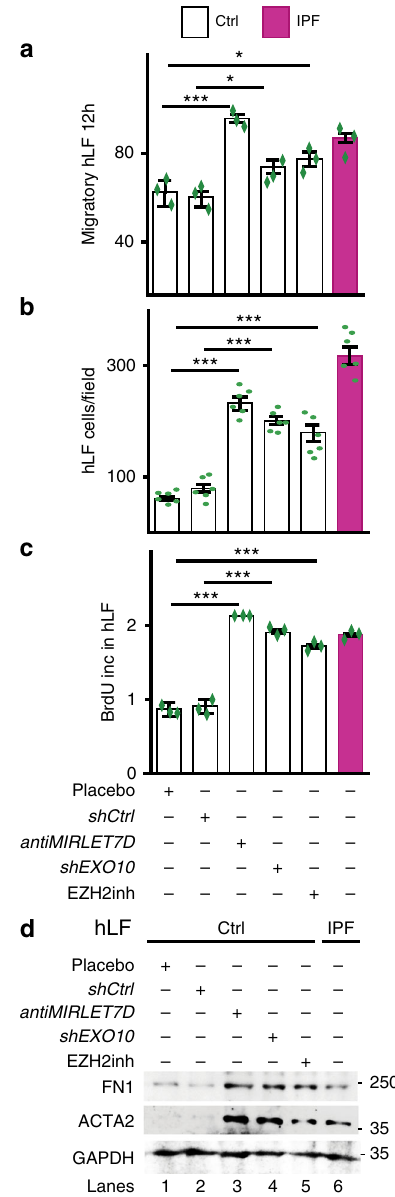
Fig. 4 Loss-of-function of MiCEE components increased fi brosis hallmarks. a – d LOF of MIRLET7D by an antagomir ( antiMIRLET7D ), EXOSC10 by a short hairpin RNA construct ( shEXO10 ), and EZH2 by the small- molecule inhibitor UNC-1999 (EZH2inh) in Ctrl human primary lung fi broblasts (hLF) increased cell migration ( a , b ), cell proliferation ( c ), and protein levels of fi brotic markers ( d ) to similar levels as in IPF hLF. Scratch migration assays ( a ) of Ctrl or IPF hLF quanti fi ed as the migratory distance 12 h after scratch (see Supplementary Fig. 3a). Quanti fi cation of Transwell invasion assays followed by hematoxylin and eosin (H&E) stain ( b ) of Ctrl or IPF hLF (see Supplementary Fig. 3b). BrdU incorporation assays ( c ) using Ctrl or IPF hLF. WB of whole-cell protein extracts from Ctrl or IPF hLF using the indicated antibodies ( d ). In all bar plots, data are shown as mean (SD) ( n = 3 biologically independent experiments for a and c ; n = 6 biologically independent experiments for b ). Asterisks in all plots, P -values after unpaired t -test, two tailed, *** P < 0.001; ** P < 0.01; * P < 0.05; ns, not signi fi cant. Source data are provided as a